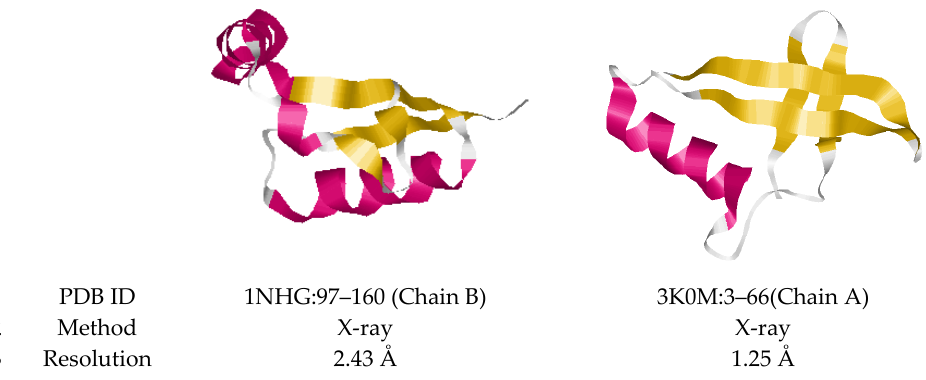
Figure 2. Ribbon model representations of 3 β -corner-like motifs. Examples of the tape model of the motif are presented. They were extracted from enoyl-ACP reductase (1NHG, Plasmodium falciparum) and peptidyl-prolyl cis-trans isomerase A (3K0M, Homo sapiens ) proteins. The coordinates of the motif in each protein (1), the experimental method for obtaining the structure (2), and the analysis resolution are indicated (3). Secondary structure elements are highlighted by color: β -stands (yellow), α‐ helix (red) and coil (white).